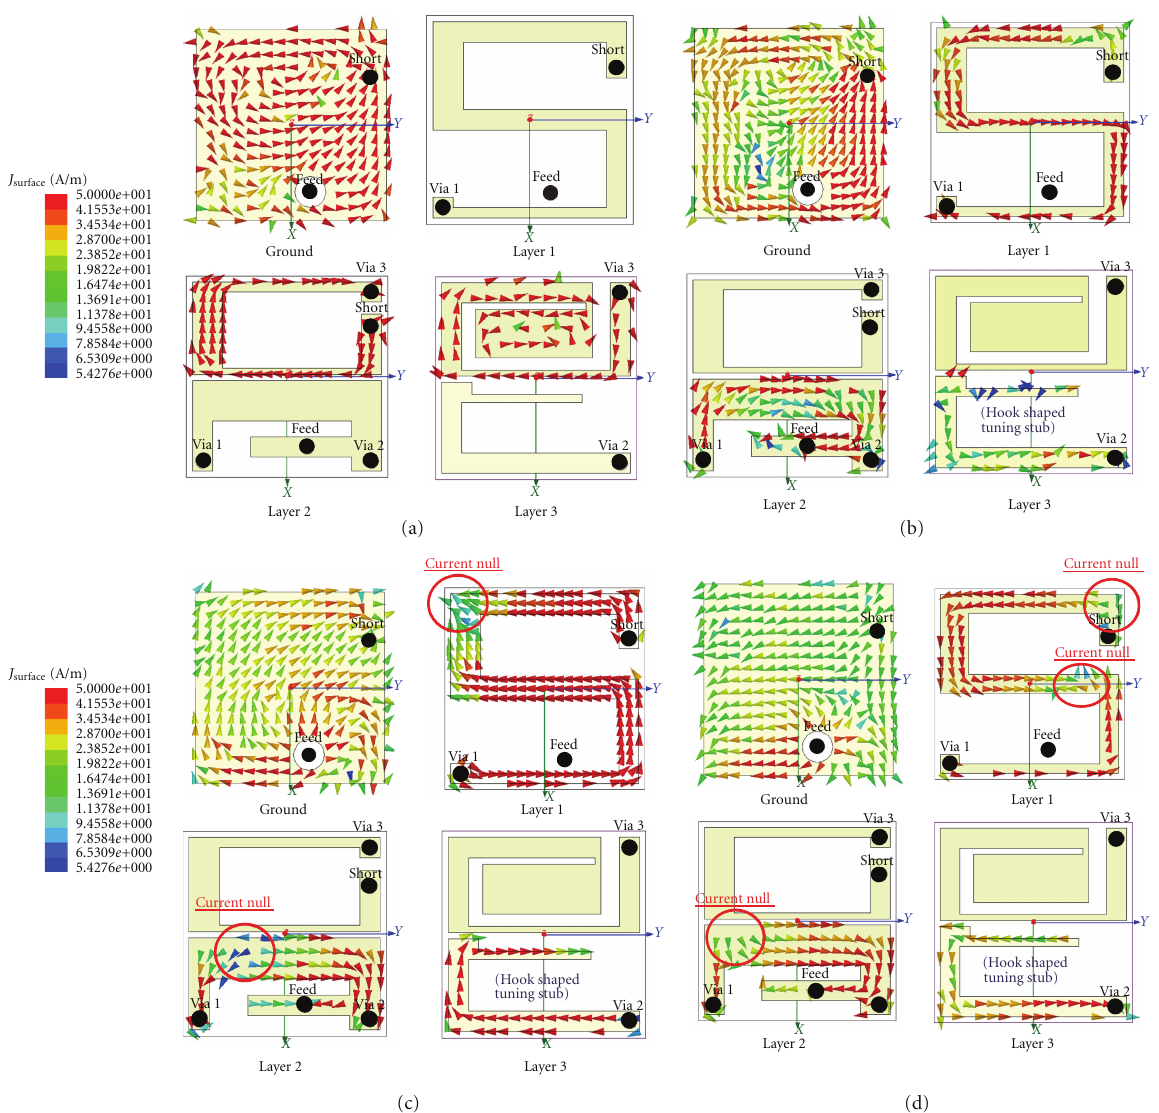
Figure 2: The simulated surface current distribution of the proposed antenna at (a) MedRadio band (401MHz), (b) ISM band (433 MHz), (c) WMTS band (1.427 GHz), and (d) ISM band